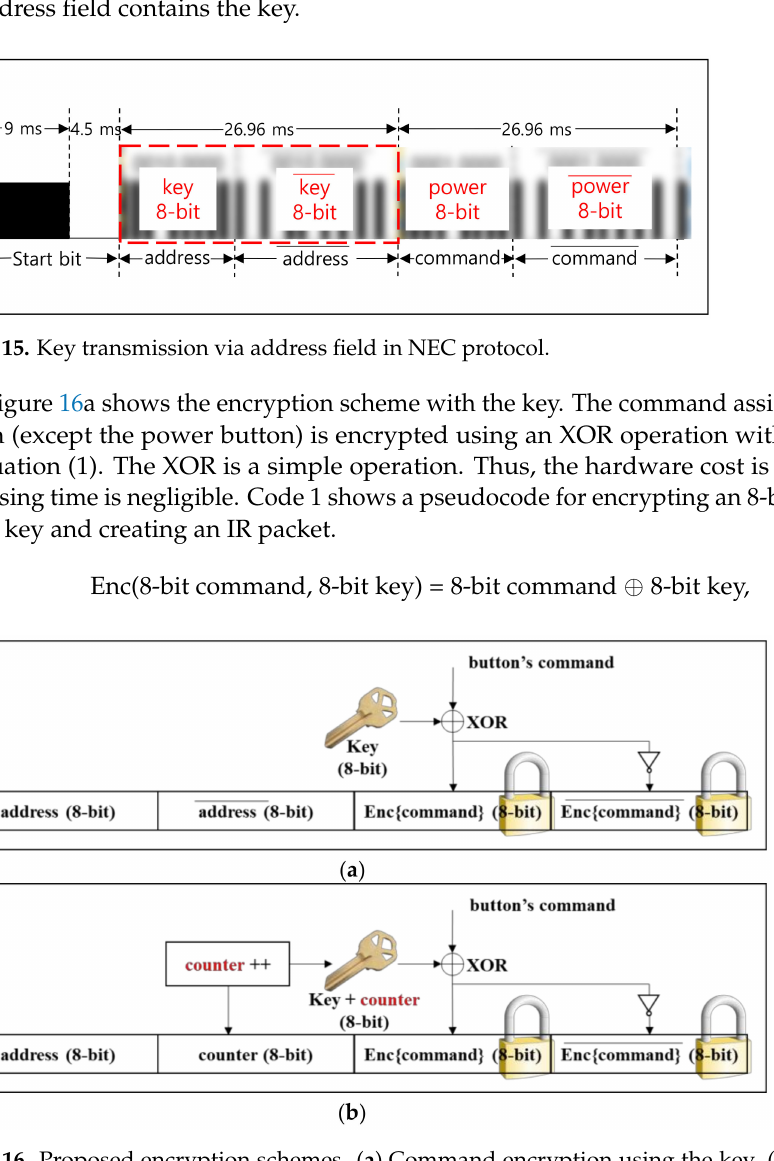
Figure 16. Proposed encryption schemes. ( a ) Command encryption using the key. ( b ) Command encryption using the key and